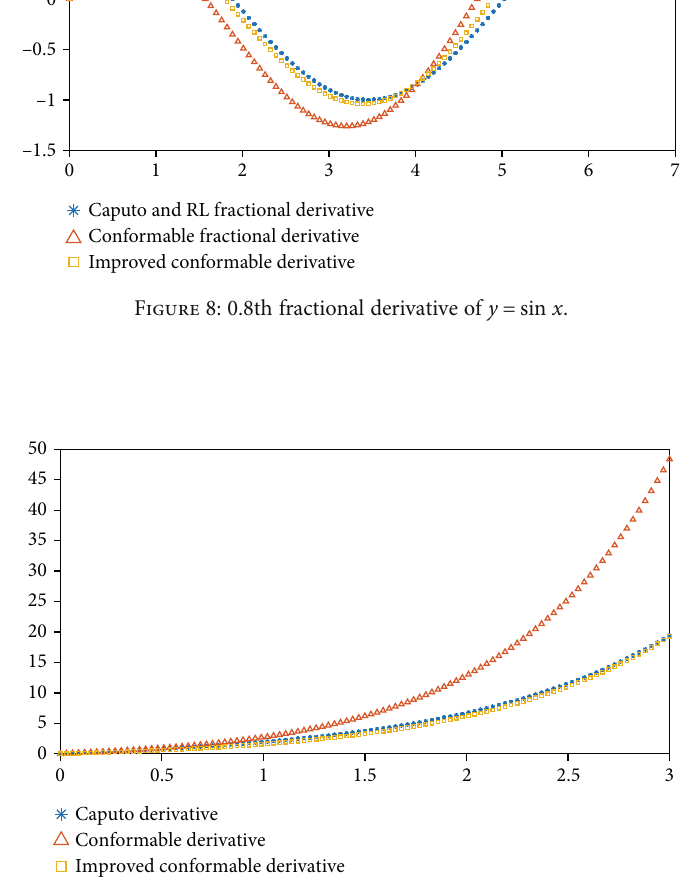
Figure 9: 0.2th fractional derivative of y = e x